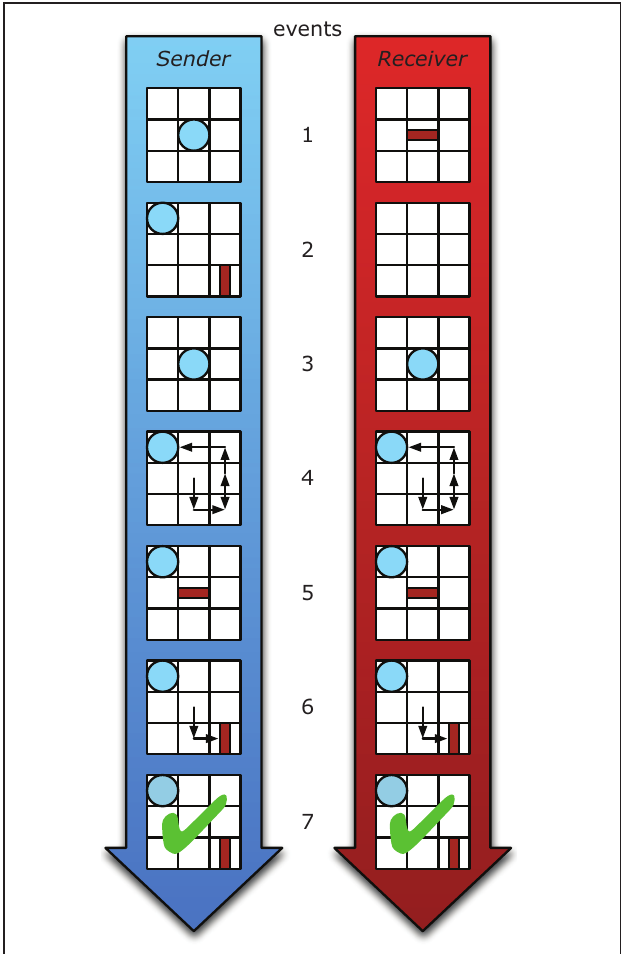
FIGURE 1 | The chronological order of phases in a trial of the Tacit Communication Game, left (in blue) is the sender and right (in red) the receiver. In phase 1 both sender and receiver are presented with their assigned token for this trial. Next, after the sender presses a start button, in phase 2 the receiver is presented with a blank screen while the sender is shown the goal configuration of both tokens and she plans her movements (unrestricted time). After the sender presses the start button again, phases 3 and 4, both players’ screens display the sender’s (blue) token and the sender is able to move her token for 5sec. It is during this phase that the sender can communicate the relevant information of the goal configuration to the receiver using movements of her token. After the sender is finished, she either presses the start button or the 5sec time limit expires and phases 5 and 6 begin. Here both players’ screens display the receivers (red) token and the receiver can move his token. Now the receiver should move his token to the location (and orientation) that he has inferred from the sender’s movement. Finally, after the receiver has finished moving his token, both players receive feedback for their performance on this trial. A green check mark denotes that both players’ tokens are in the exact same location and orientation as depicted in the goal configuration shown to the sender in phase 2; and a red cross (not shown in this figure) denotes that the tokens are not placed